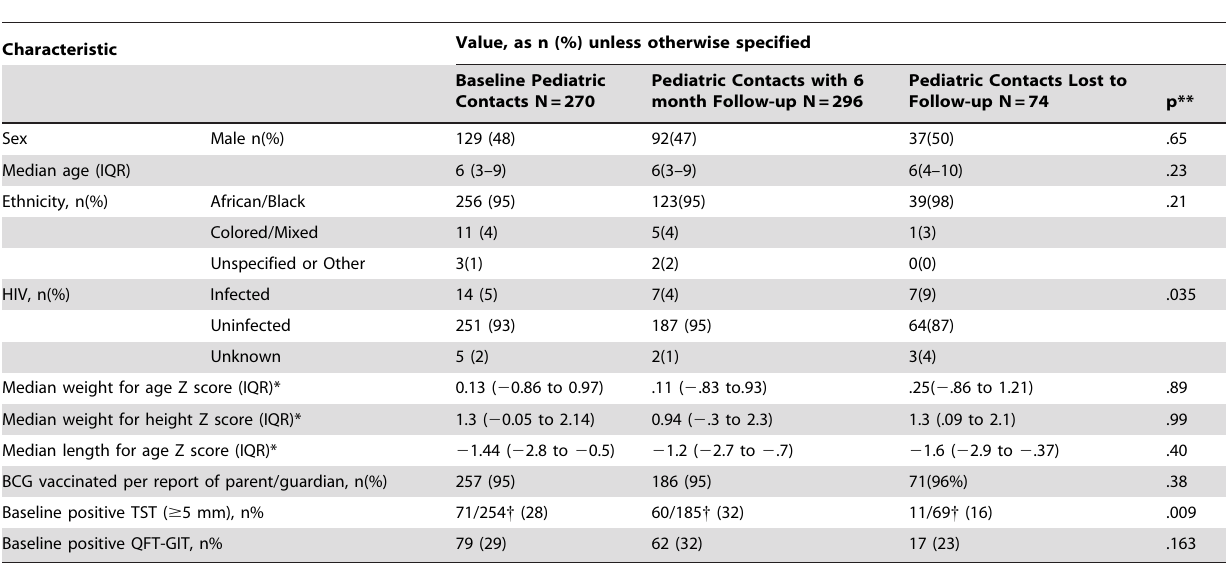
Table 1. Characteristics of study participants at enrollment and